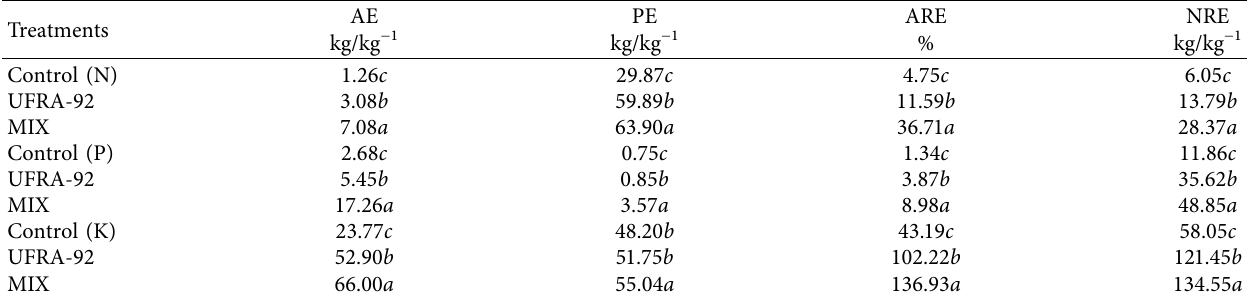
Figure 7: Efect of inoculation with Bacillus subtilis (UFRA-92) and Trichoderma asperellum +UFRA-92 on the shoot dry mass nutritional content of Urochloa brizantha cv. Marandu by the t test ( p < 0 . 05). Table 2: Efect of inoculation with Bacillus subtilis (UFRA-92) and Trichoderma asperellum+ UFRA-92 (MIX), associated with 75% N, 50% P 2 O 5 , and 50% K 2 O, on agronomic efciency indices (EA), physiological efciency (PE), apparent recovery efciency (ARE), and nutrient response efciency (NRE) of Urochloa brizantha cv.